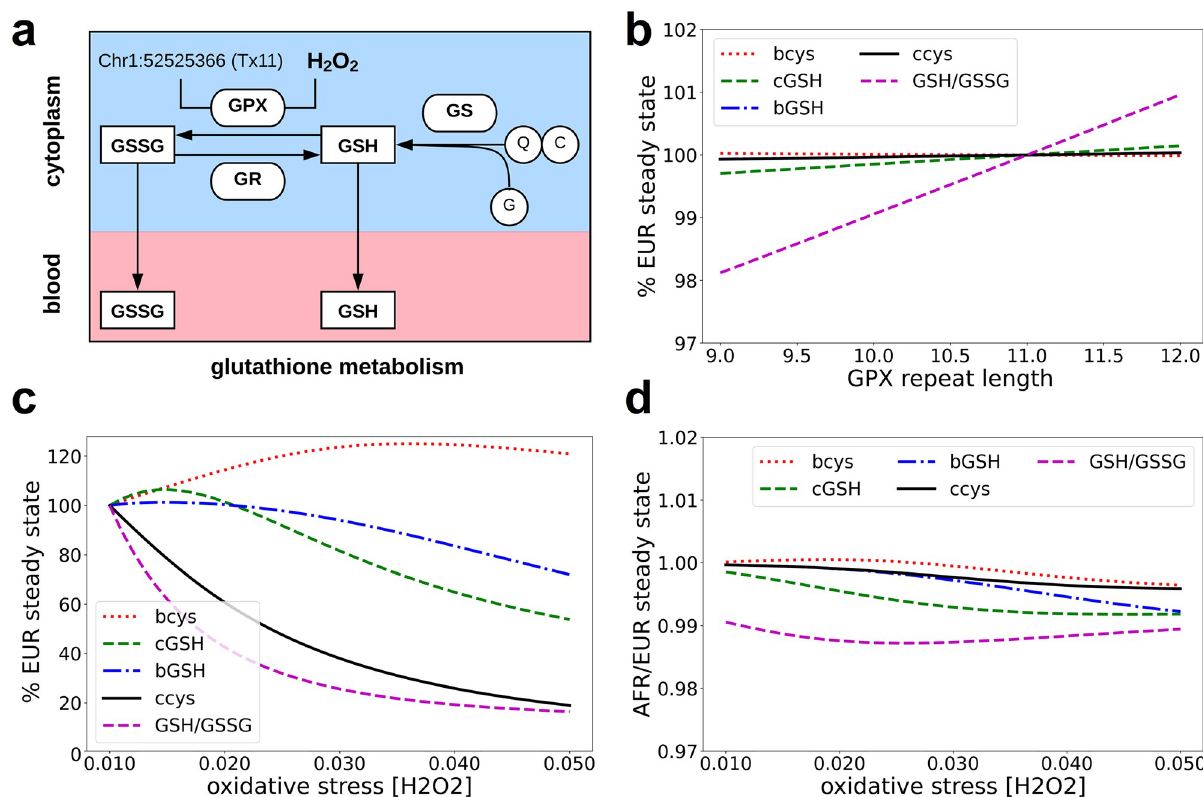
Fig 5. A mathematical model of glutathione metabolism predicts differential response to oxidative stress in Africans and Europeans. a , We modify the Reed model of glutathione metabolism to include effects of an eSTR (chr1:52525366) associated with GPX7 expression. Subsequent in silico experiments track the ratio [GSH]/[GSSG] indicative of the redox status of the cell. b , Predicted steady state concentrations of key metabolites are affected by eSTR array length. Array length deletions (shorter than 11bp) mimic the effects of oxidative stress. c , The European eSTR allele run to steady state under various concentrations of H 2 O 2 faithfully reproduces the original Reed model. d , Steady state concentrations predicted for the African model (10bp allele) under various concentrations of H 2 O 2 reveal differences in the oxidative stress response.